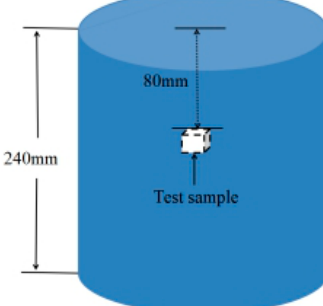
Figure 1. Sampling position of alloy.